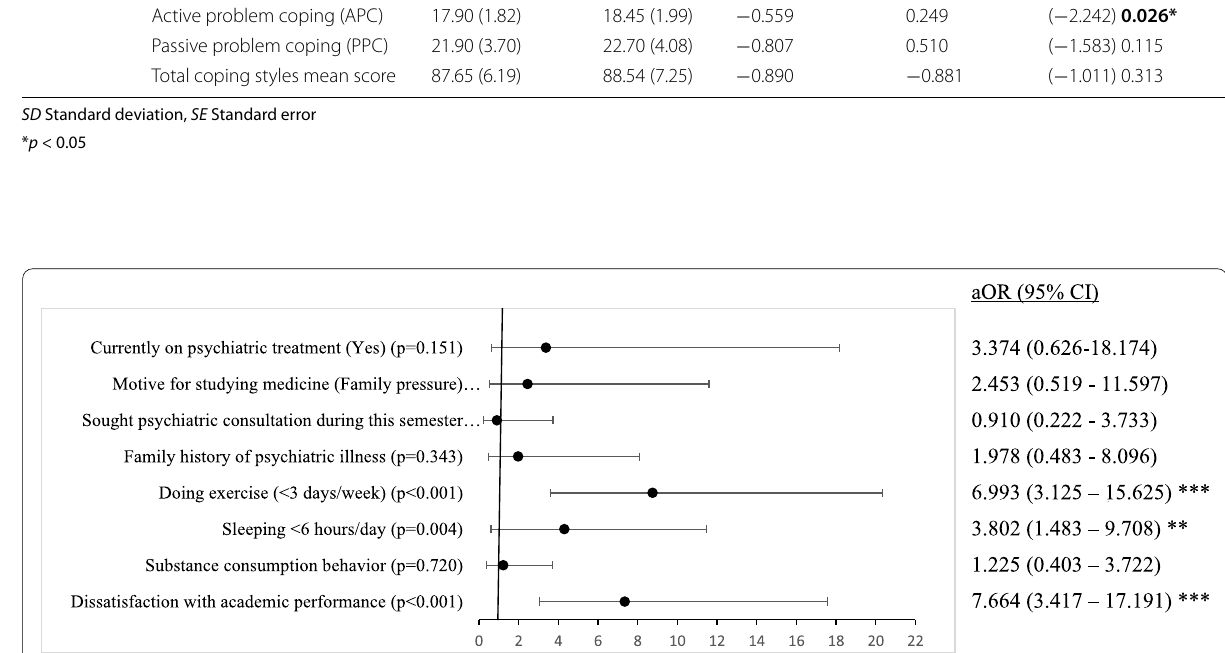
Fig. 1 Forest plot showing binary logistic regression analysis of psychological morbidities in pre/para-clinical medical students. 95% CI, 95% confidence interval; aOR, adjusted odd ratio; odd ratio adjusted for current age, gender, residence (born/raised before entering the course), type of family, and living status during the course. ** p < 0.01; *** p <